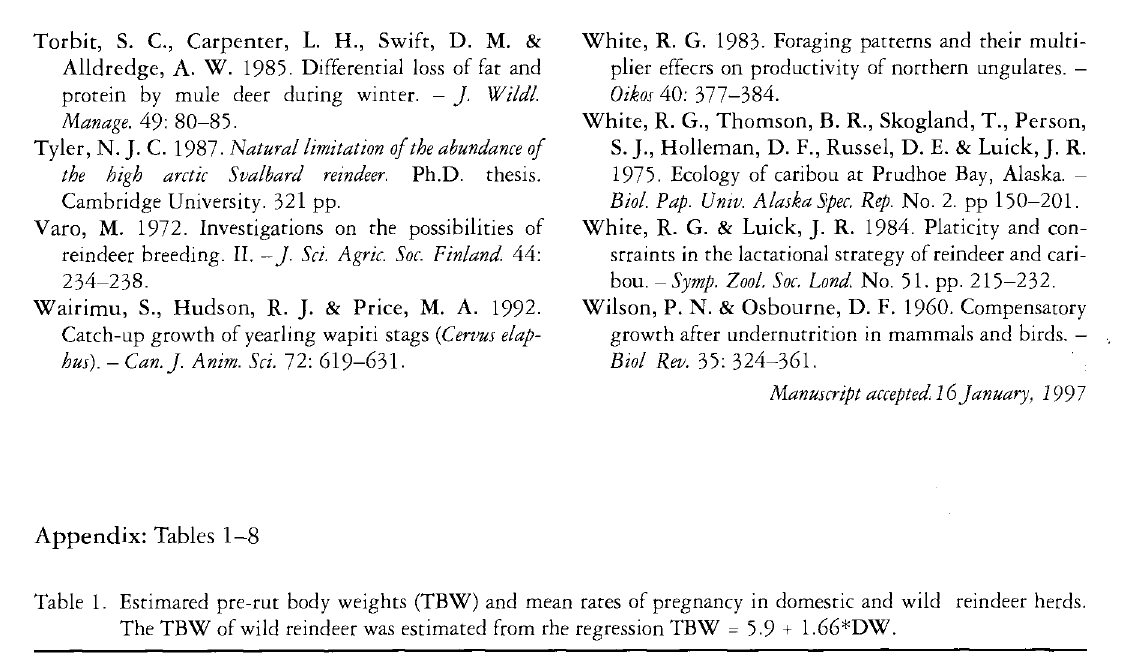
Table 1. Estimared pre-rut body weights (TBW) and mean rates of pregnancy in domestic and wild reindeer herds. The TBW of wild reindeer was estimated from rhe regression TBW = 5.9 + 1.66*DW. Area/herd Period